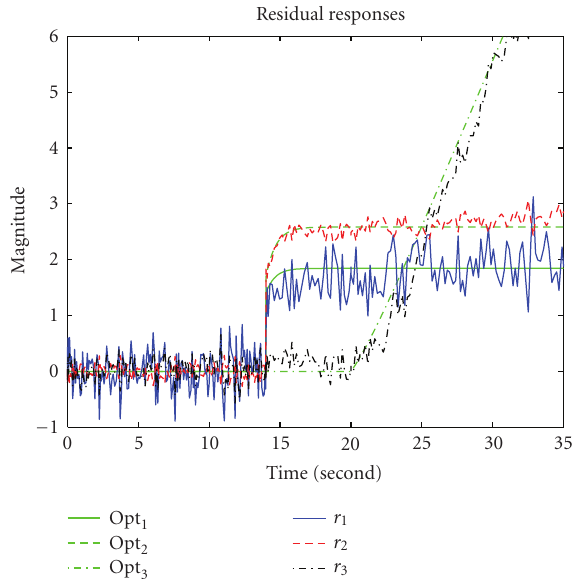
Figure 2: Time response of the residual before the optimization.